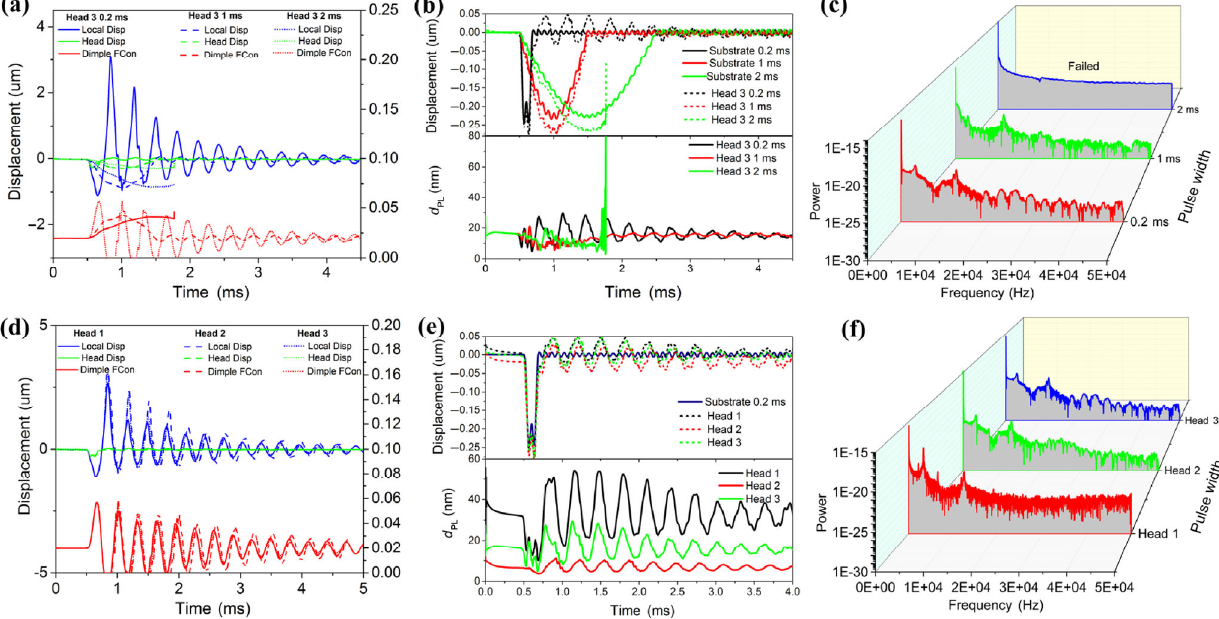
Fig. 8 Negative shock response of the SPAS model: (a) components response, (b) substrate, head, and the head at different pulse widths, (d) components response, (e) substrate, head, and different ABS